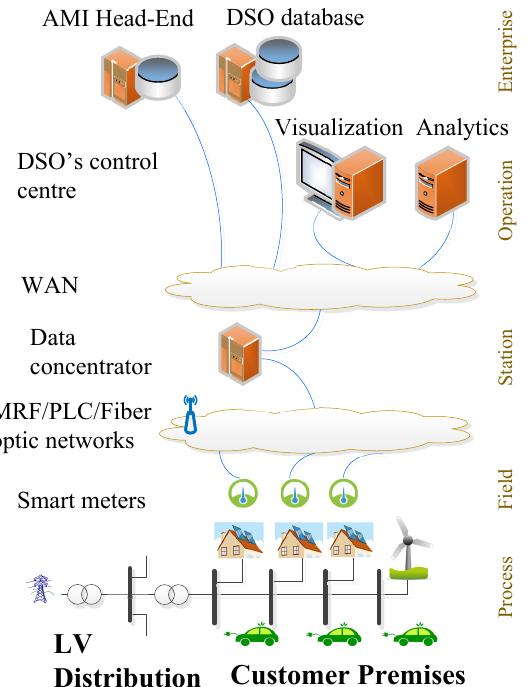
Figure 1. Schematic layout of a typical advanced metering infrastructure (AMI) infrastructure in Nordic